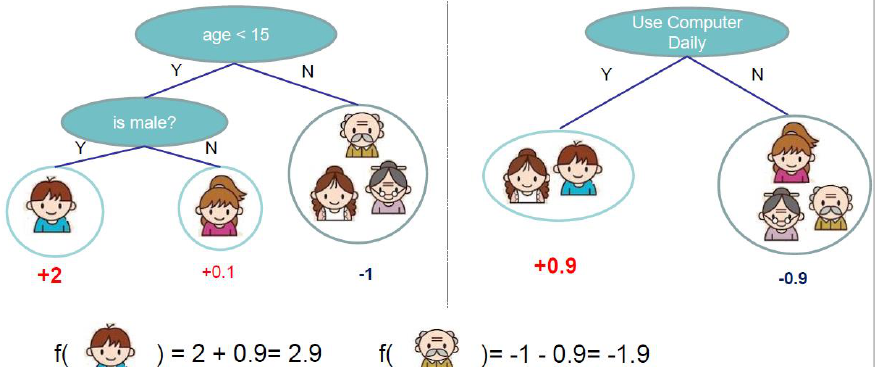
Figure A1. Tree ensemble. Source: Chen and Guestrin (2016).